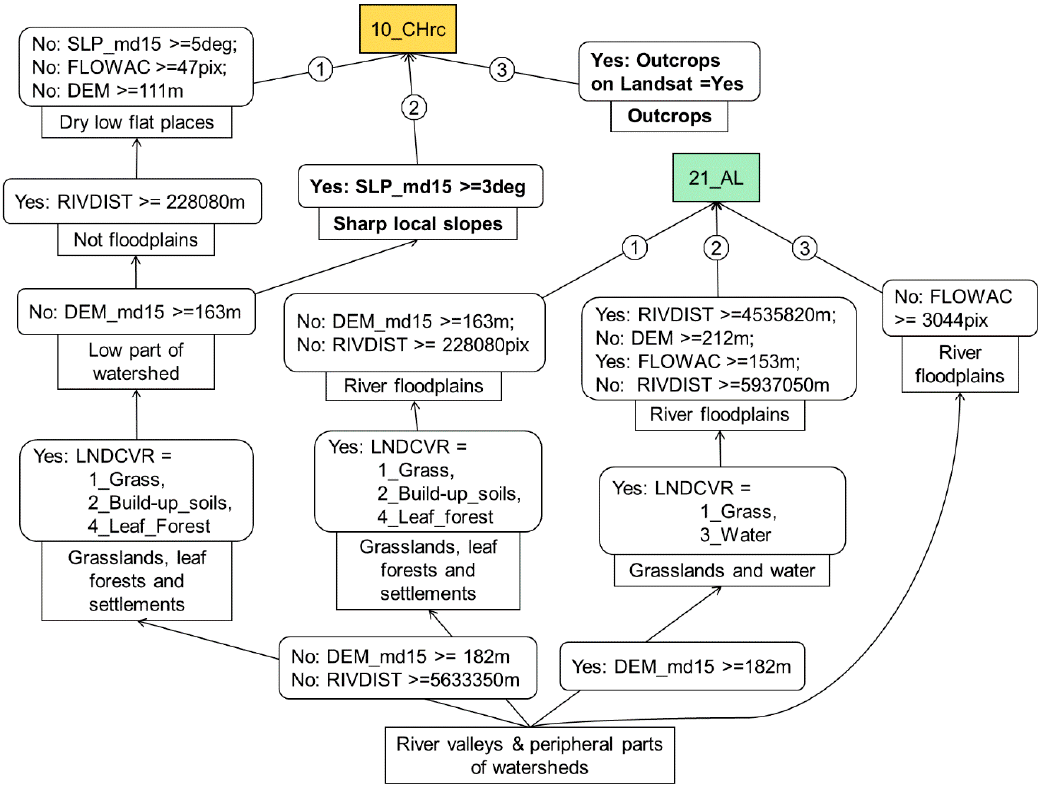
Figure 11. Expertly corrected classification tree using three methods: modeling with reworked factor maps, the manual addition of expert rules, and expert correction using direct recognition of remote sensing data.